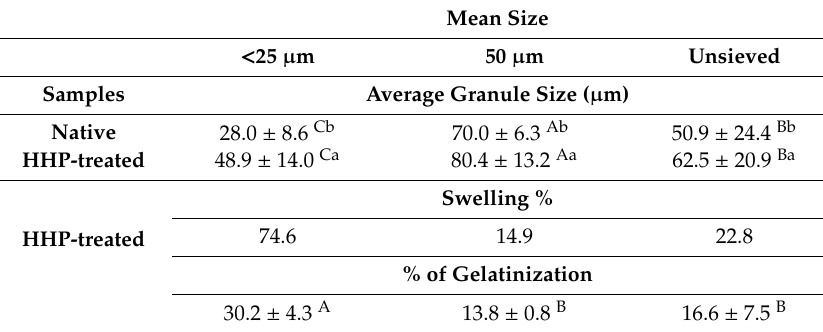
Table 2. Swelling behavior and % of gelation of potato starch suspensions (20% w / w) of di ff erent particle size, after pressure (600 MPa for 15 min at 25 ◦ C) and thermal treatments, determined from optical measurements. Mean Size < 25 µ m 50 µ m Unsieved Samples Native